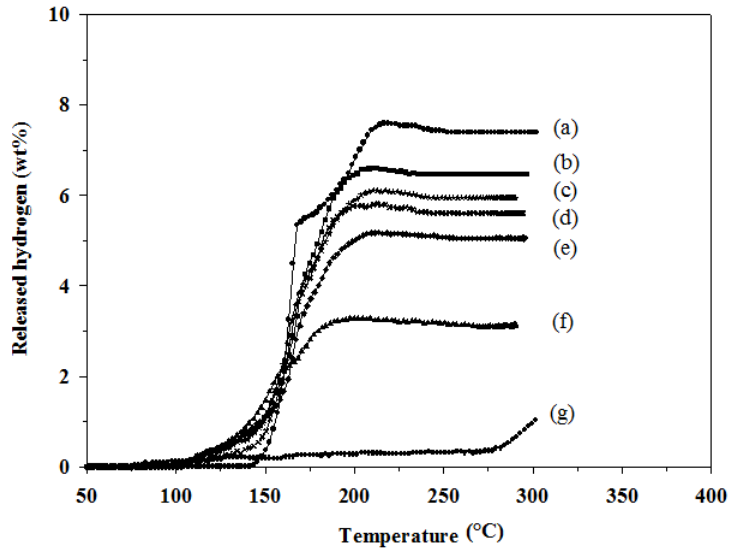
+LiBH ; ( d ) 4LiAlH 4 4 . 4